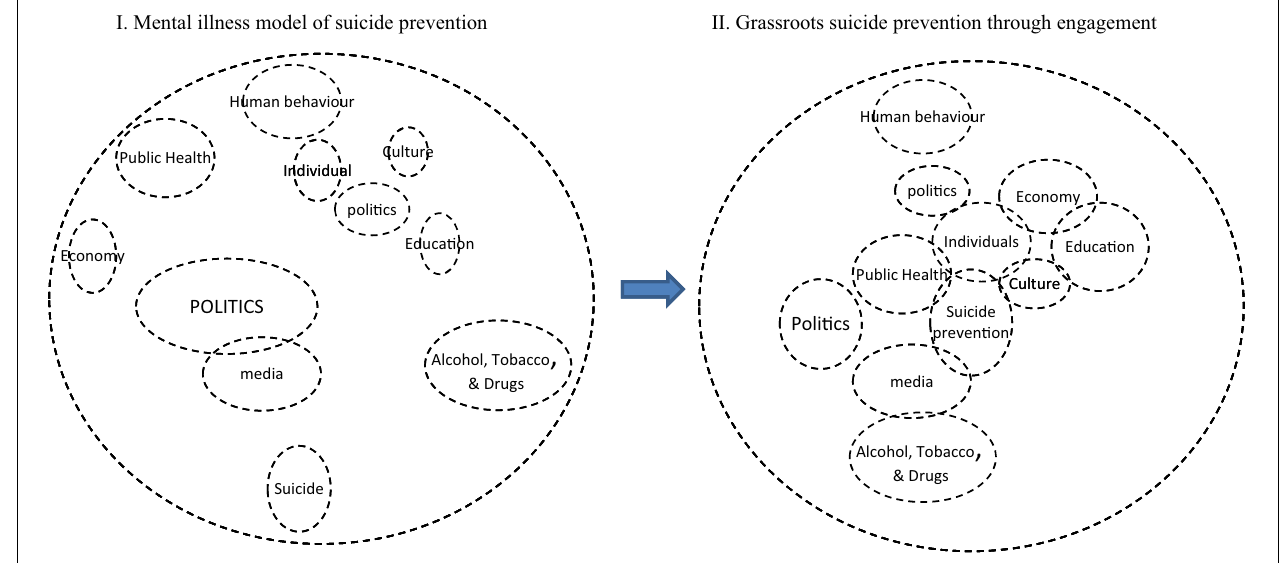
FIGURE 3 | Graphic visualization of suicide prevention .